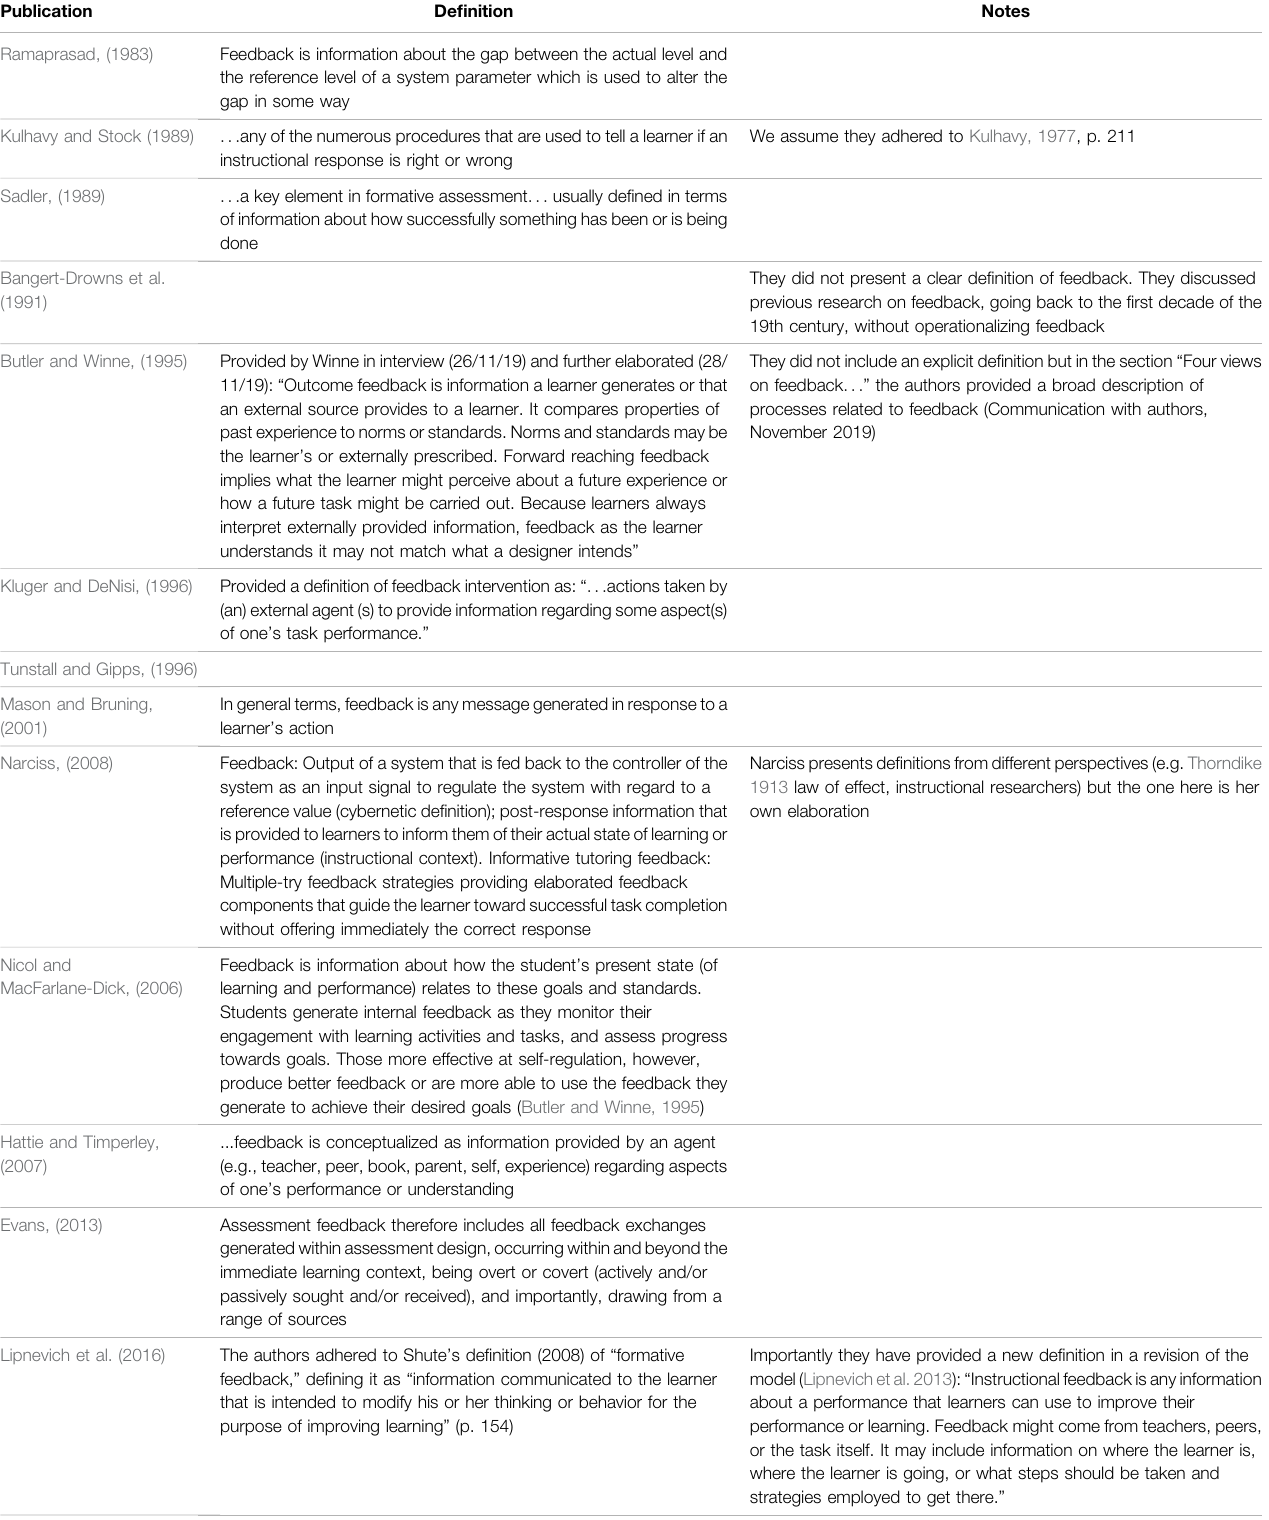
TABLE 3 | De fi nitions of feedback used in the different